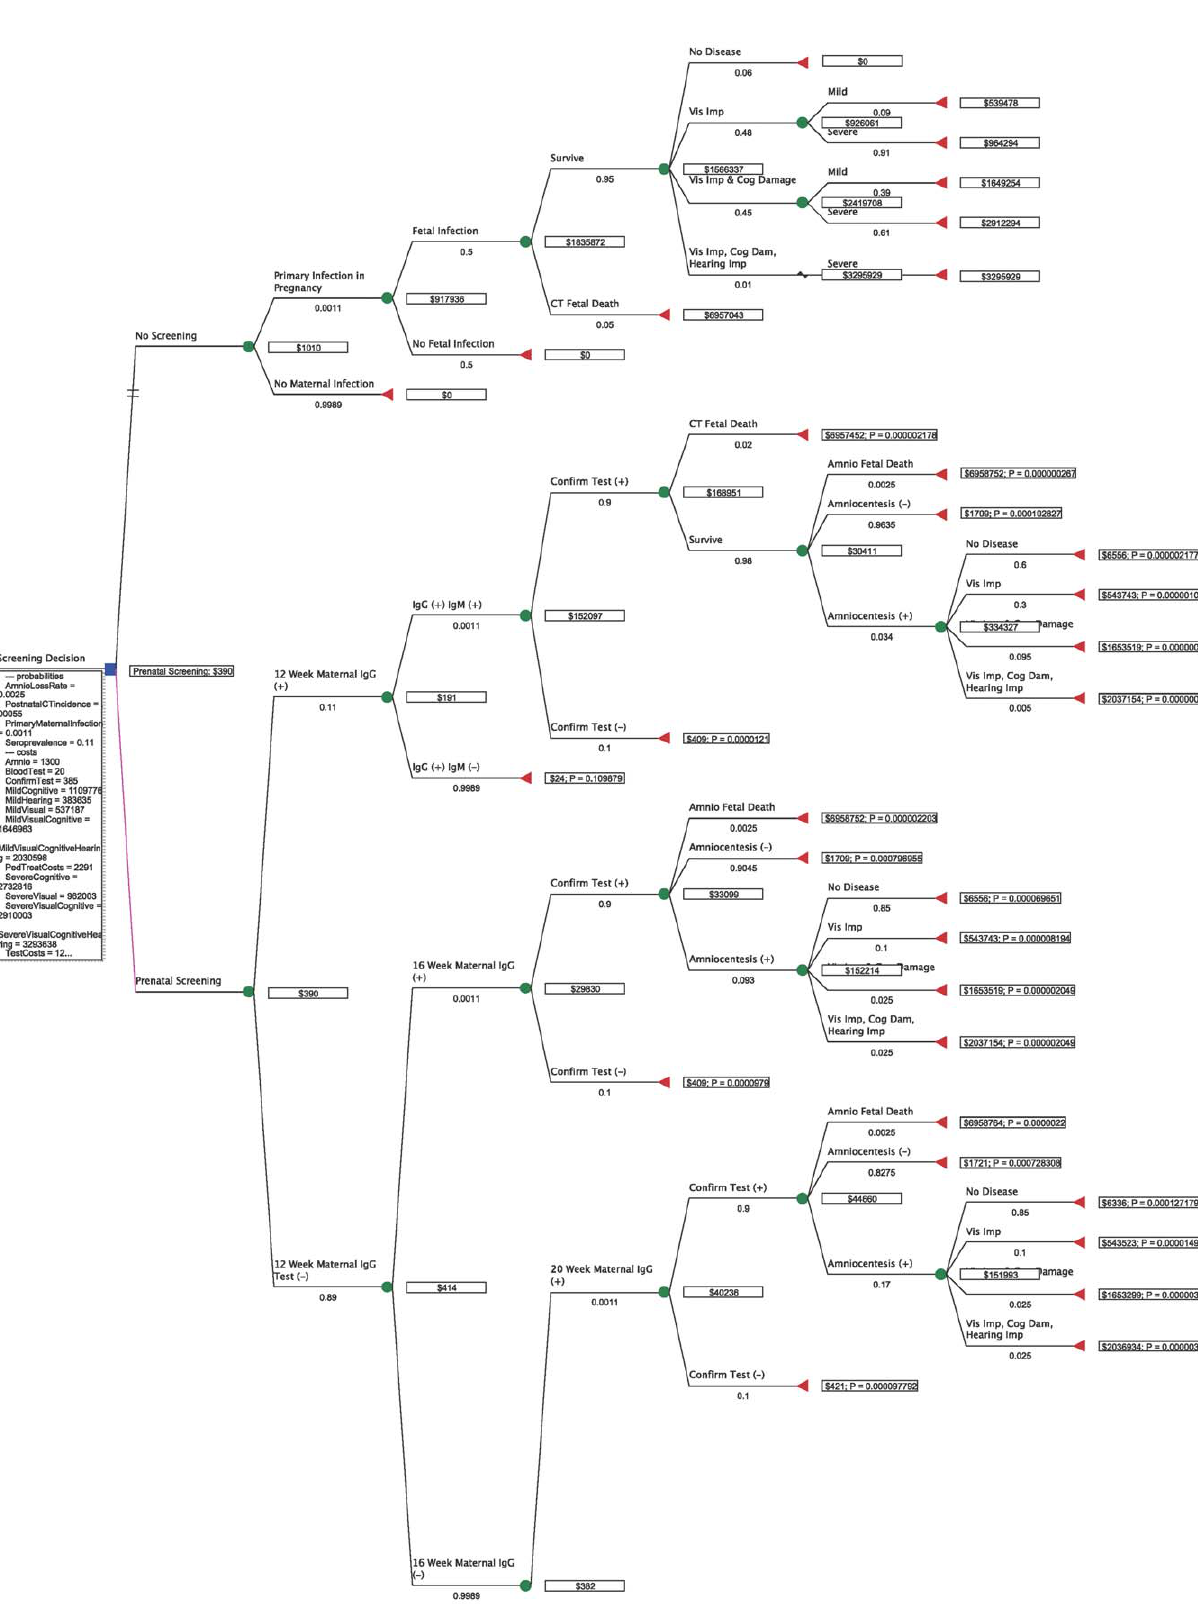
Figure 3. Decision tree with monetary values for costs and optimal path (top).